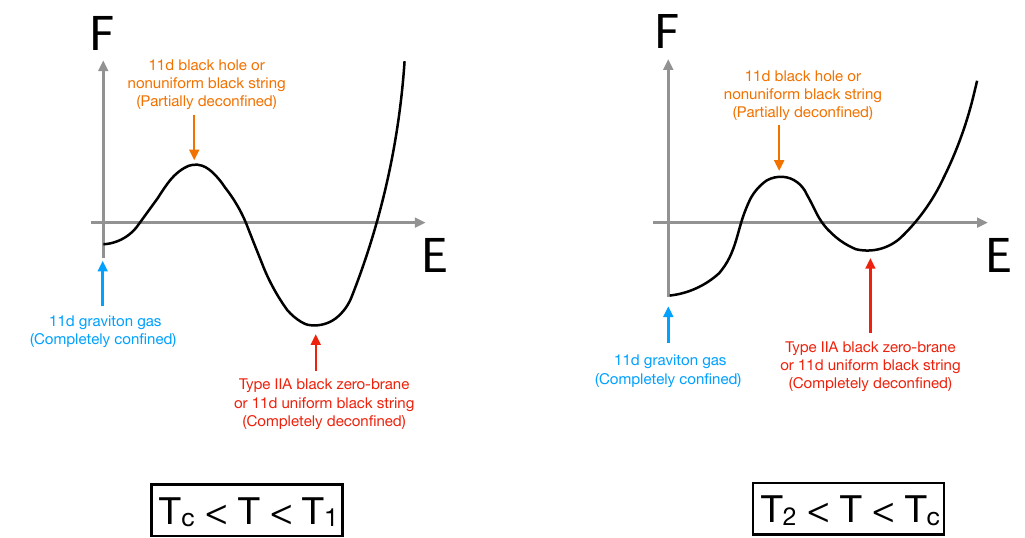
Figure 3. A conjecture for the relationship between free energy F versus energy E at fixed temperature T in the BFSS matrix model. An 11d Schwarzschild black hole gives the local maximum which separates the two minima. (See appendix E for why negative specific heat implies a free energy